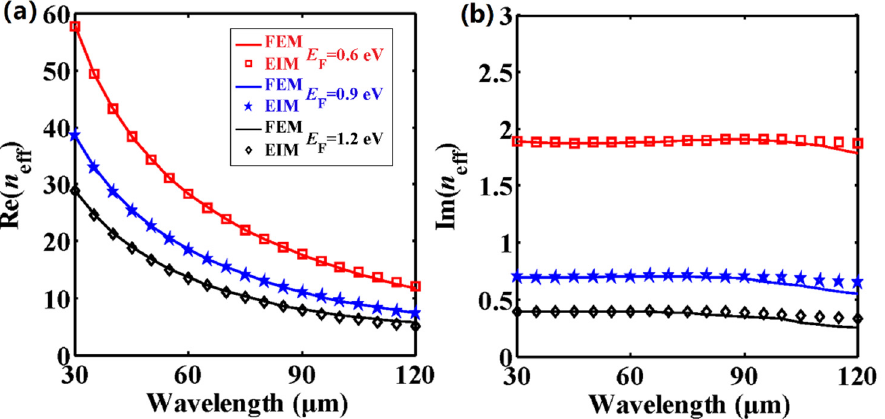
Figure 6. Group velocity v g of the TM 0 and TM 1 modes in DLGSPWG with respect to the frequency. w = 4 μ m, E F = 0.6 eV. Note that the blue and black lines nearly overlap each other. Solid lines for TM 0 and dashed lines for TM 1 .